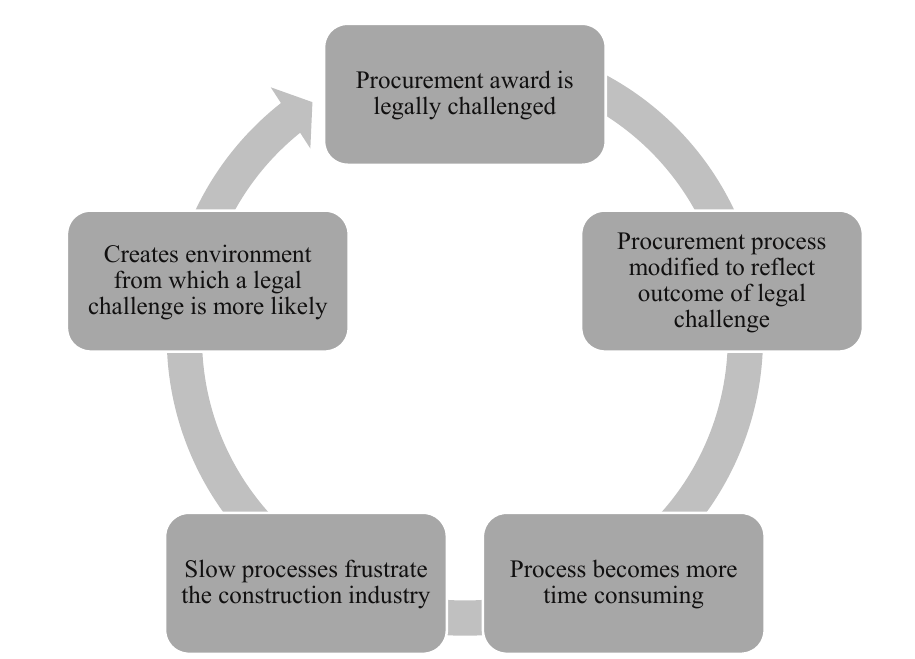
Figure 11. Respondents’ views on the number of challenges, when presented with actual number in last seven years.